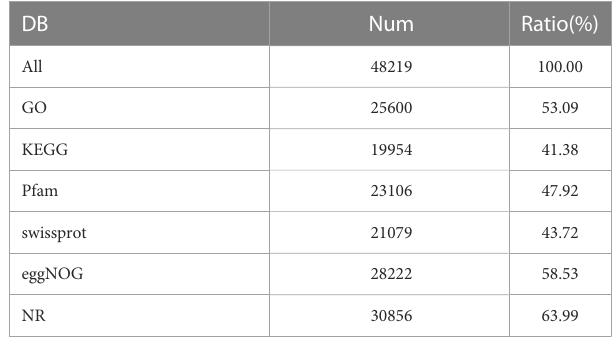
TABLE 1 The result of a functional annotation.